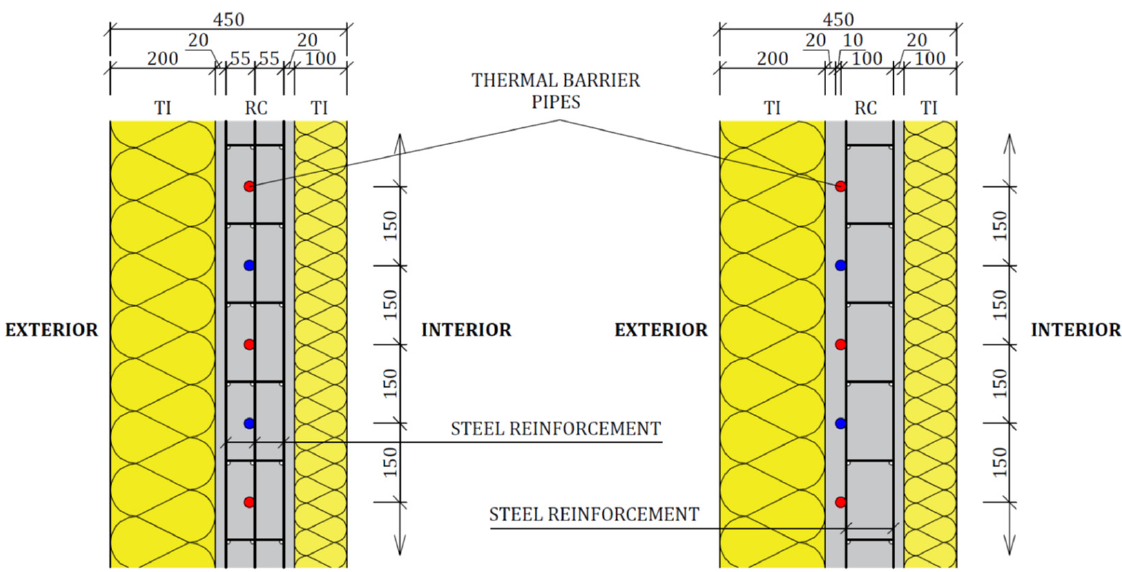
of the panel structure (Figure 19, right).